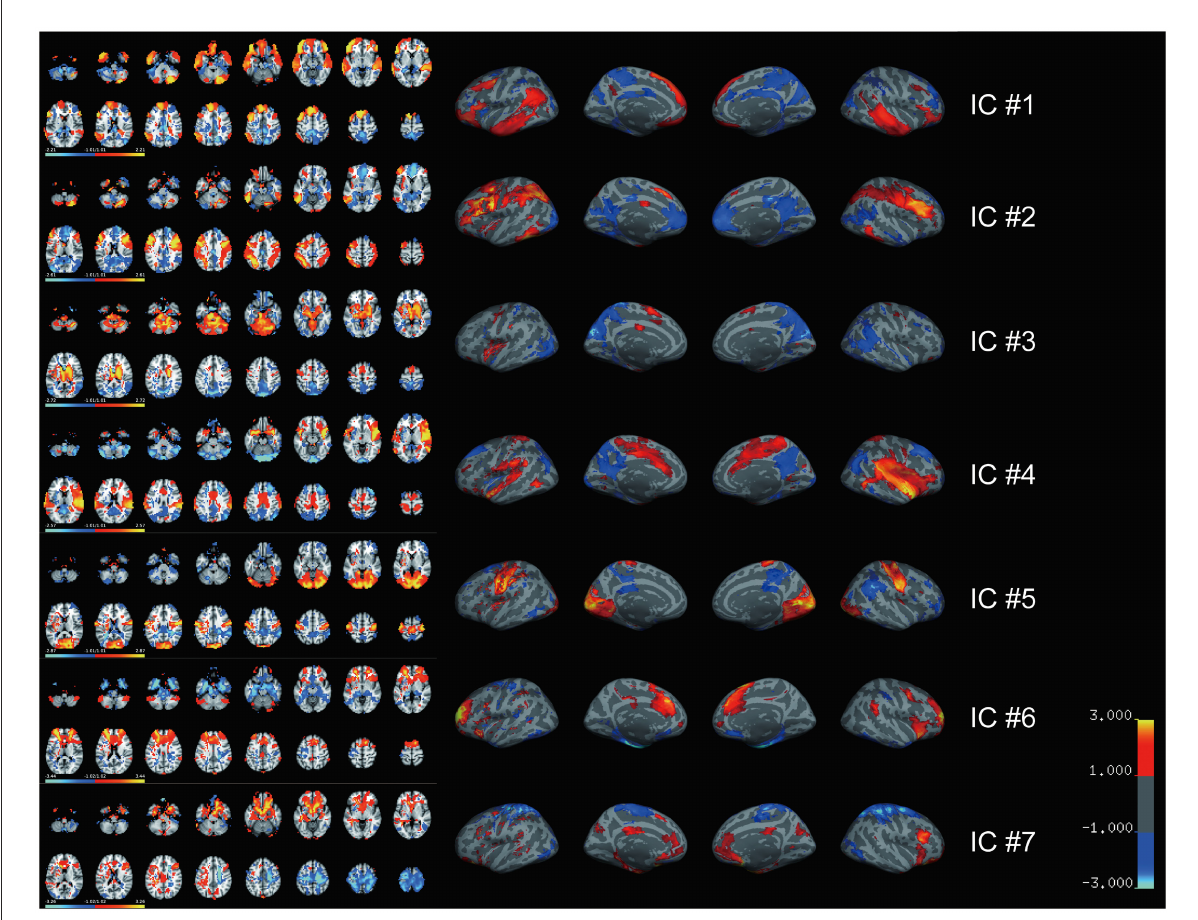
FIGURE2 Seven independent spatial maps are generated by lesion-based independent component analysis. Seven spatially independent components derived from ICLM are illustrated with both volume (left) and surface (right) maps. The major brain regions included in each spatial map are listed. IC#1: inferior frontal gyrus, superior frontal gyrus, and middle frontal gyrus together with some other regions in premotor cortex; IC#2: fusiform gyrus, inferior parietal lobe, middle frontal gyrus, inferior frontal gyrus, and superior parietal lobule; IC#3: thalamus, pons, caudate, and precuneus; IC#4: temporal pole, insula, and supramarginal gyrus; IC#5: occipital lobe, precentral gyrus, and postcentral gyrus; IC#6: anterior cingulate, superior frontal gyrus, medial frontal gyrus, and inferior frontal gyrus; IC#7: middle frontal gyrus, orbitofrontal cortex, postcentral gyrus, precentral gyrus, and inferior frontal gyrus. Color bar indicates the weight of each voxel in the corresponding IC. IC, independent